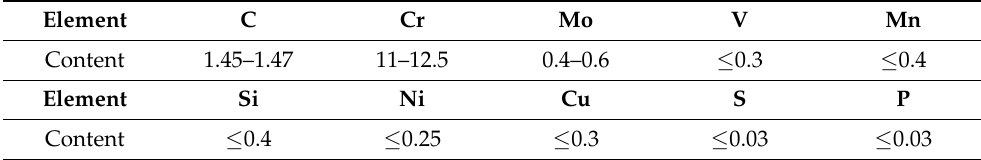
Figure 2. Microstructure of hardened steel Cr12MoV. Table 1. Chemical composition of Cr12MoV hardened steel